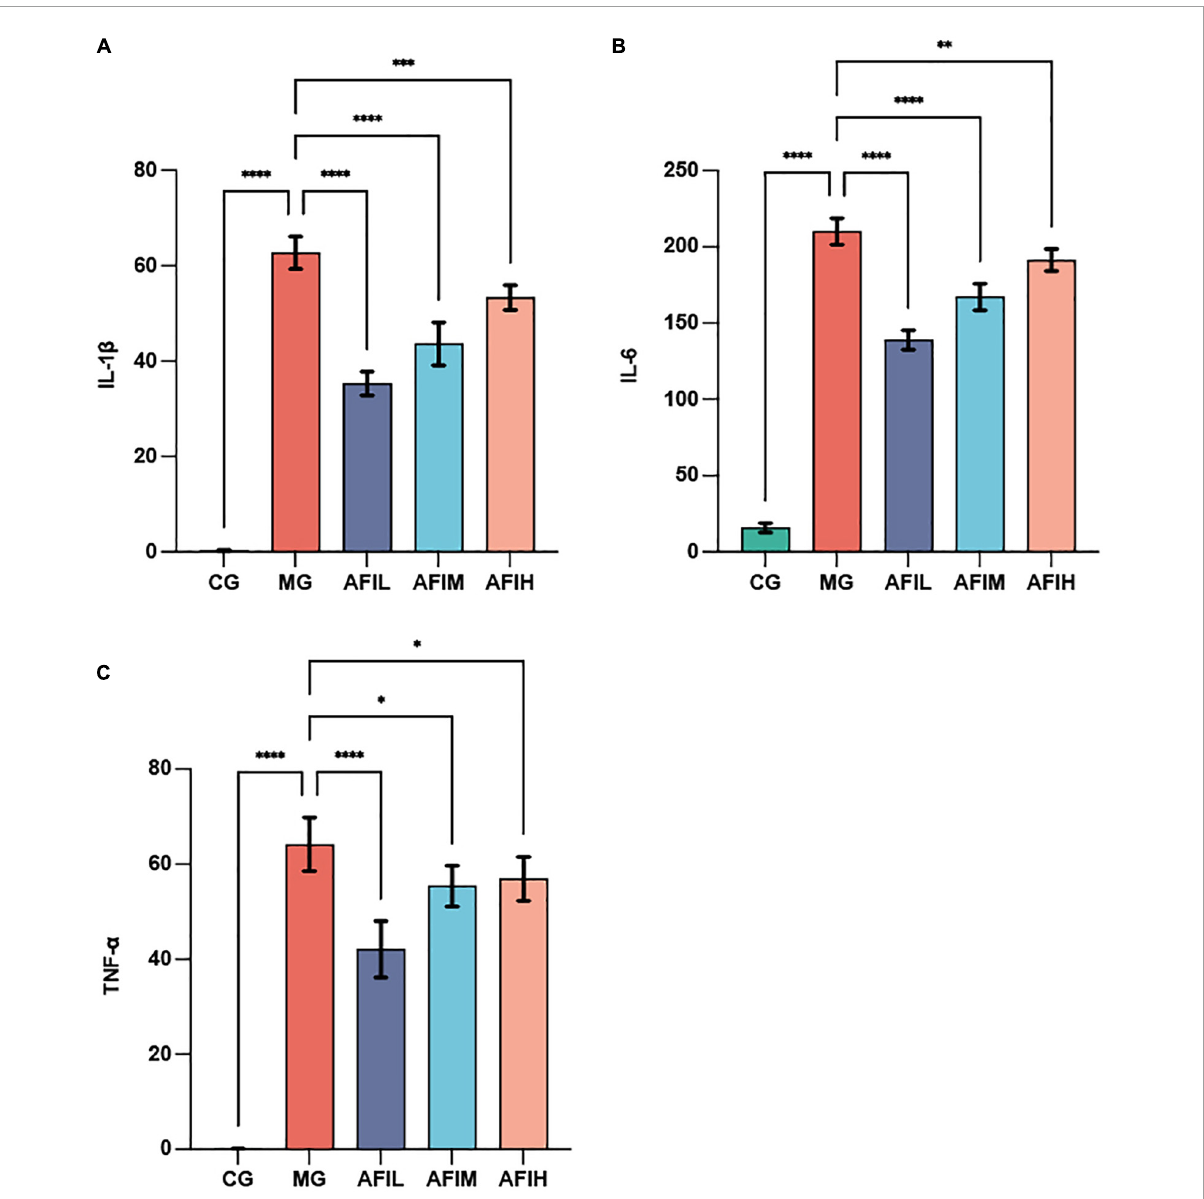
FIGURE2 The effect of AFI on serum inflammatory factors. Bars represent the mean ± SE ( N = 6). (A) Serum IL-1 β levels. (B) Serum IL-6 levels. (C) The TNF- α level in the serum. The value of P < 0.05 is marked with “ ∗ ”. The value of P < 0.01 is marked with “ ∗∗ ”. The value of P < 0.005 is marked with “ ∗∗∗ ”. The value of P < 0.001 is marked with “ ∗∗∗∗